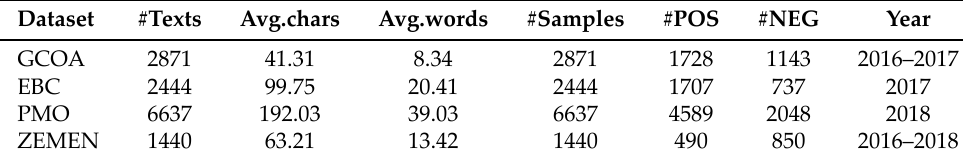
Table 2. User‑generated Amharic Comments on Social Media Dataset Description.